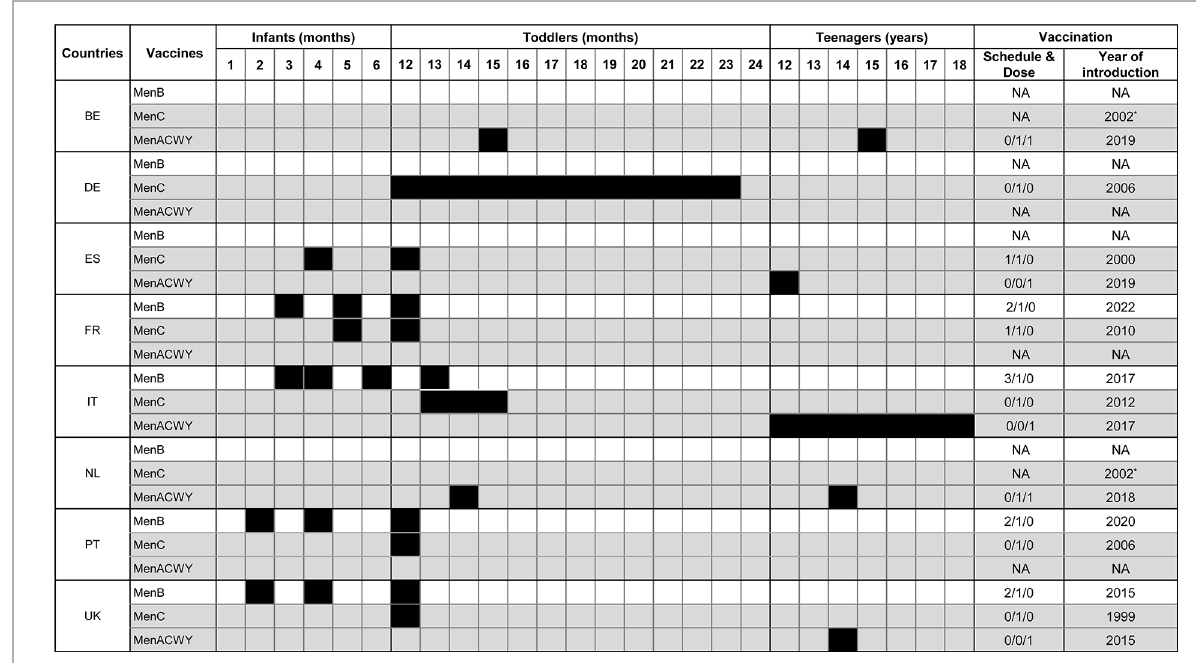
FIGURE 4 National recommendations for meningococcal vaccination in 2022 in selected European countries. BE, Belgium; DE, Germany; ES, Spain; FR, France; IT, Italy; NA, not applicable; NL, Netherlands; PT, Portugal; UK, United Kingdom. *Since then, switch from MenC to MenACWY. Vaccination schedules are presented by age group (infants, toddlers, or teenagers). Figures (n/n/n) indicate the number of doses of each vaccine per period. Catch-up programs are not mentioned. MenB: protein-based vaccine (white); MenC or MenACWY: conjugate vaccine (gray). Black boxes indicate age at vaccination. For example, in the UK, the MenC dose is administered at 12 months of age, and in Germany between 12 and 23